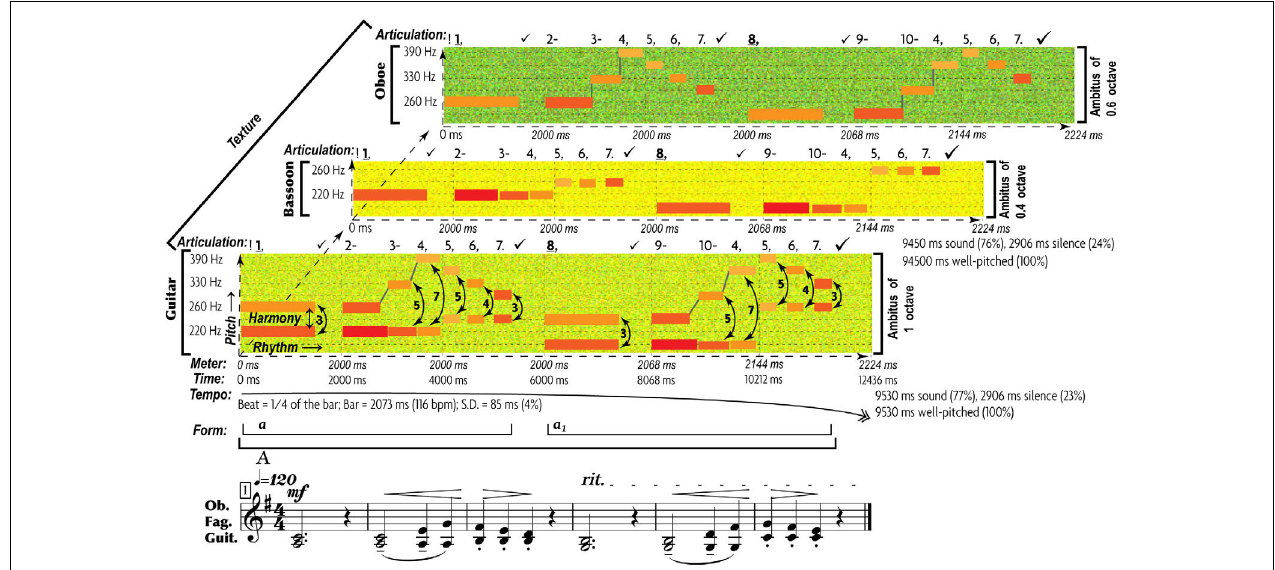
FIGURE 1 | 11 AEs in a musogram of classical instrumental music. At the bottom of the figure, the conventional musical notation represents the same content as the three musograms above it. The lowest musogram (guitar) contains all the AEs marked out and named. Its horizontal axis (horizontal dashed arrow) represents time, vertical axis (vertical dashed arrow) frequency, depth axis (diagonal dashed arrow) the aspect of texture . The latter joins all three musograms. Small colored rectangular bars indicate tones. Their vertical relation represents pitch , with dash guidelines referencing frequency values. The changes in distance between the concurrent (superimposed) rectangles indicate harmony . The rectangular length represents rhythm . The breaks and the gray lines that connect the consecutive rectangles as well as the numbers above the frequency grid comprise an aspect of articulation . Each tone is numbered, checkmarks indicate pauses (the bigger the pause the larger the checkmark), and punctuation signs reflect the grouping of tones. Dashes mark the connected tones (legato), commas—disconnected tones within the same phrase, periods—the end of a phrase, and exclamation marks—the phrasal opening. Bold and underlined numbers indicate anchor-tones (stressed by duration, dynamics, and frequency of occurrence). The gray lines represent connectivity: discrete pitches are connected by vertical lines, whereas portamento pitches by tilted lines. The coloring of rectangles represents dynamics: from the loudest in yellow to the softest in blue. Thin vertical dashed lines indicate meter —inferred from well-articulated occurrences of anchor-tones and longer rests. Tempo averages all metric units, expressed in msec and beats-per-minute. The standard deviation shows how flexible the tempo is. A solid arrow with a double arrowhead reflects the tempo changes: ascending for accelerations, while descending for decelerations. Form reflects the thematic organization of the material, indicated by horizontal brackets and letters: thinner brackets and lowercase letters for motifs, and thicker brackets and uppercase letters for phrases. Each new material is marked by a new letter, and variation—by a subscript number. Register is represented by the coloration of the grainy filling of the ambitus: from a deeper green for the darkest timbre to yellow for the lightest timbre. In this example, oboe uses its darkest register, bassoon—its faintest register, whereas guitar—its medium register. Harmonicity (see Table 3 ) is indicated by the relative thickness and the geometric shape in representation of tones: the greater the harmonic richness, the thicker the rectangular bars, whereas the noisier the sound, the more irregular the fuzzy shapes (not present in this particular example). For thorough explanation of this method of visualization see Appendix 1 in Supplementary Material